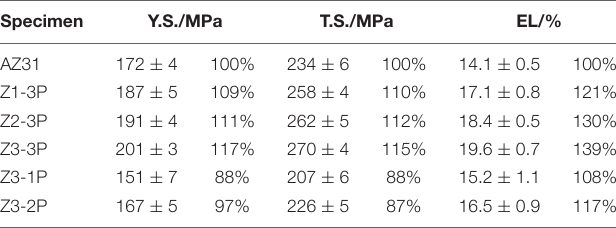
TABLE 3 | Tensile properties of AZ31 alloy and AZ31/ZrO 2 composites. Specimen